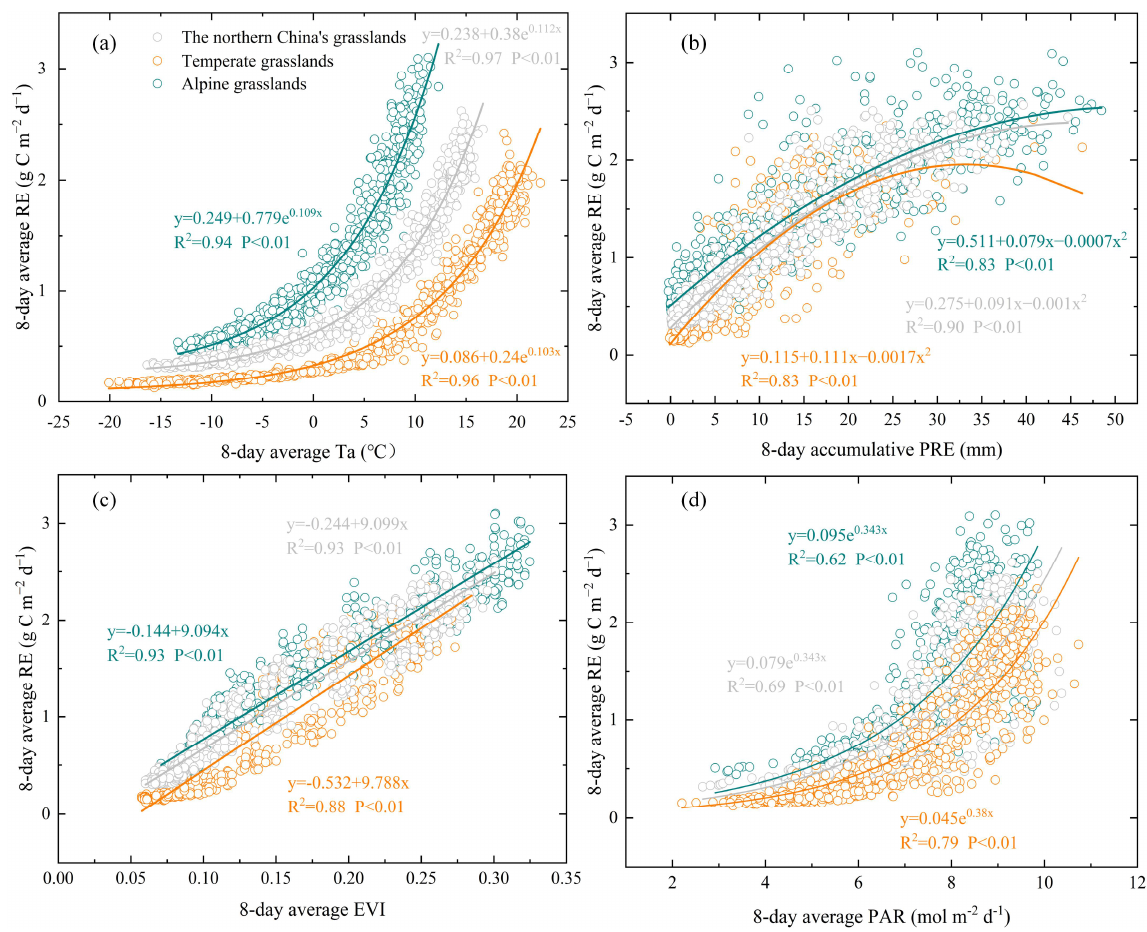
Figure 7. Seasonal dynamic correlation between RE and ( a ) Ta, ( b ) PRE, ( c ) EVI, and ( d ) PAR at eight-day timescale from 2001–2015 in the northern China’s grasslands overall, alpine grasslands, and temperate grasslands, respectively.